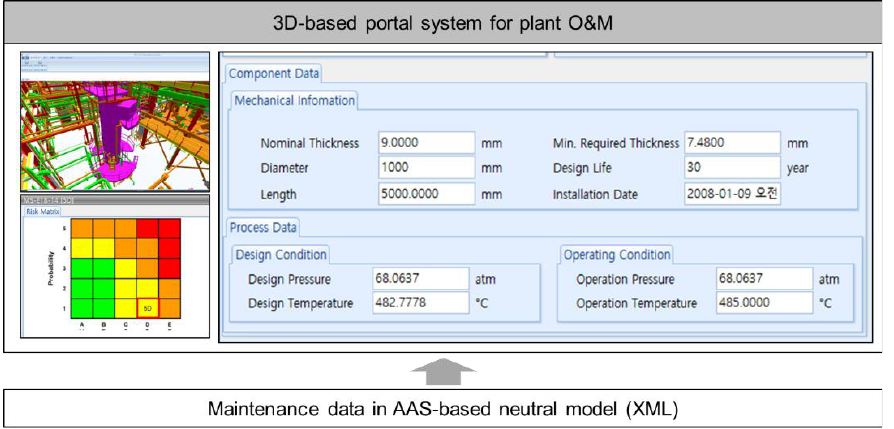
Figure 15. Maintenance data transfer to a 3D-based portal system.